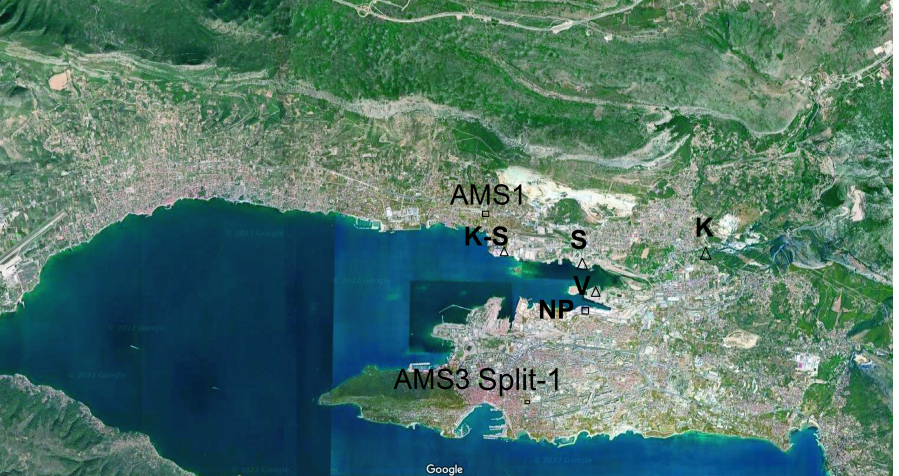
Figure 1. The position of the AMS 3 Split-1 measurement station (latitude: 43°30′39′′ N, longitude: 16°26′56′′ E, elevation: 46 m) in Split, Croatia, and the AMS 1 measurement station Kaštel-Sućurac (latitude: 43°32′53′′ N, longitude: 16°26′5′′ E) (the location of the station is marked with a square) [55]. The positions of cement plants in Kaštel-Sućurac (“K-S”), Solin (“S”), Klis (ˇK”), as well as the asbestos cement plant in Vranjic (“V”) (the location of the plant is marked with a triangle) and northern port (“NP”) of Split (the location is marked with a square).